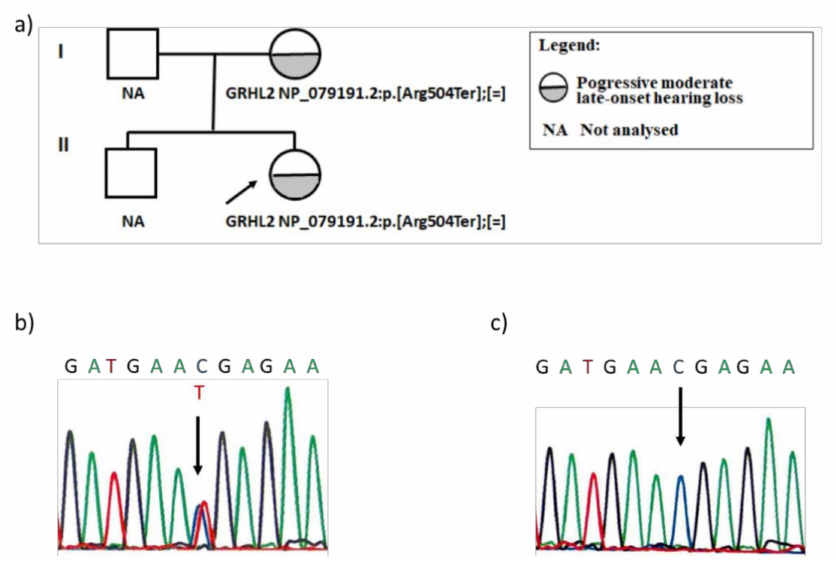
Figure 3. Family pedigree ( a ) and electropherogram of the nucleotide sequence of the GRHL2 gene exon 12 encompassing novel variant NM_024915: c.1510C>T (NP_079191.2: p.Arg504Ter) ( b ); normal sequence ( c